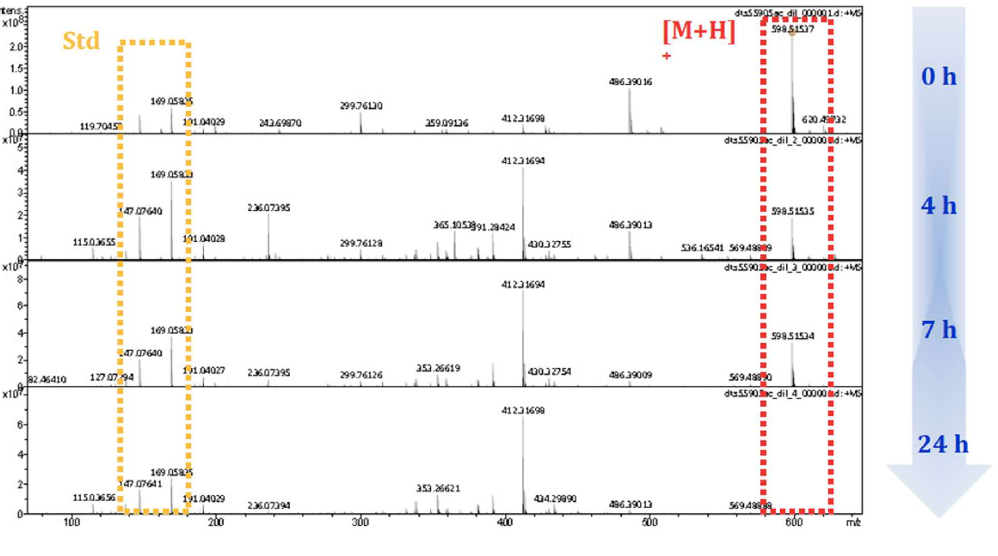
Figure A1. ( a ) TEM images of worm-like micelles of L-G 1 bound to heparin, scale bar = 100 nm. On drying, the worm-like micelle-heparin complex hierarchically assembles into larger aggregates. Worm like micelles can most clearly be visualized curved into ‘U shapes’ in the lower aggregates — multiple cylindrical micelles appear to be packed together in these regions. ( b ) TEM images of spherical micelles of L-G 2 bound to heparin, scale bar = 50 nm. Some free micelles can be seen within the image, but most have further aggregated hierarchically on binding to heparin and drying to yield a nanostructure which in this case is ca. 50 nm in diameter. Adapted from [26] with the permission of The Royal Society of Chemistry.